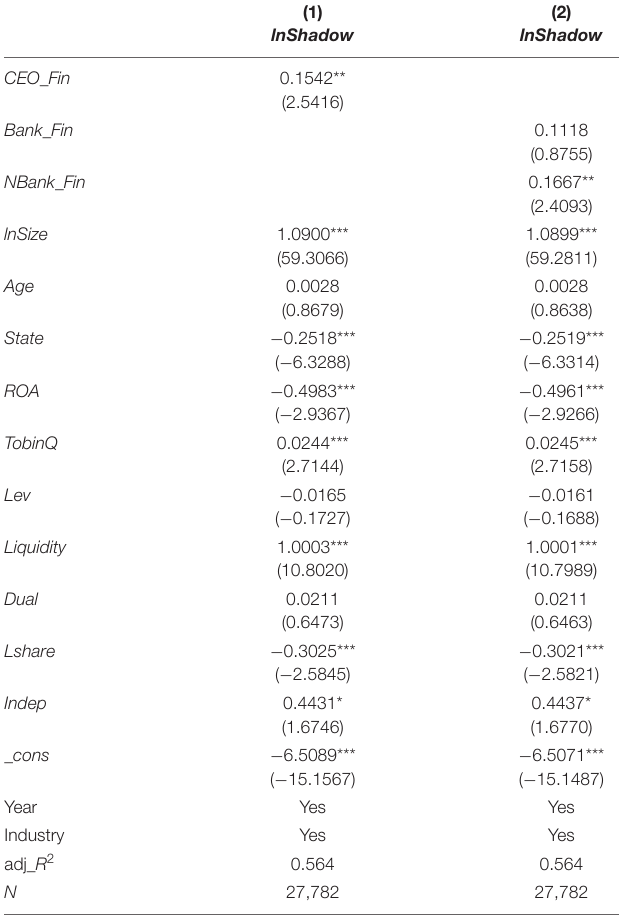
TABLE 3 | CEOs’ FB and its categories and shadow banking business of non-financial